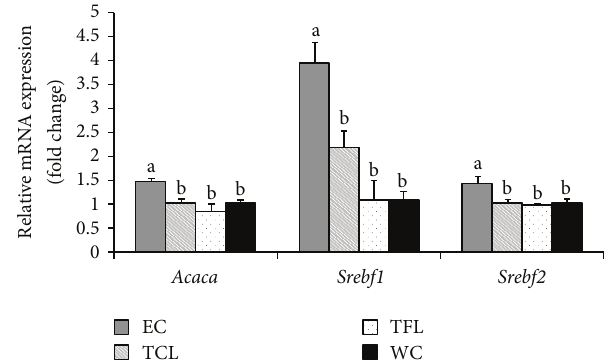
Figure 3: Relative mRNA expressions of key lipid metabolism- related genes. Acaca : acetyl-coenzyme A carboxylase alpha; Srebf1 : sterolregulatoryelementbindingtranscriptionfactor1; Srebf2 :sterol regulatory element binding transcription factor 2; TFL: tea-flavor liquor; TCL: traditional Chinese liquor; EC: ethanol control; WC: water